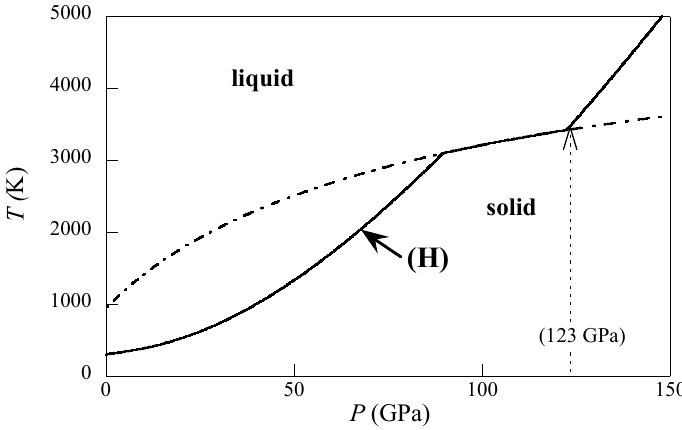
Figure 4. Computed phase diagram of Al, showing the melting curve (mixed line) and the Hugoniot curve (solid line). The dotted arrow shows that the 123 GPa shock breakout pressure, calculated in the experiment of Figure 3b, implies shock-induced melting throughout the sample.